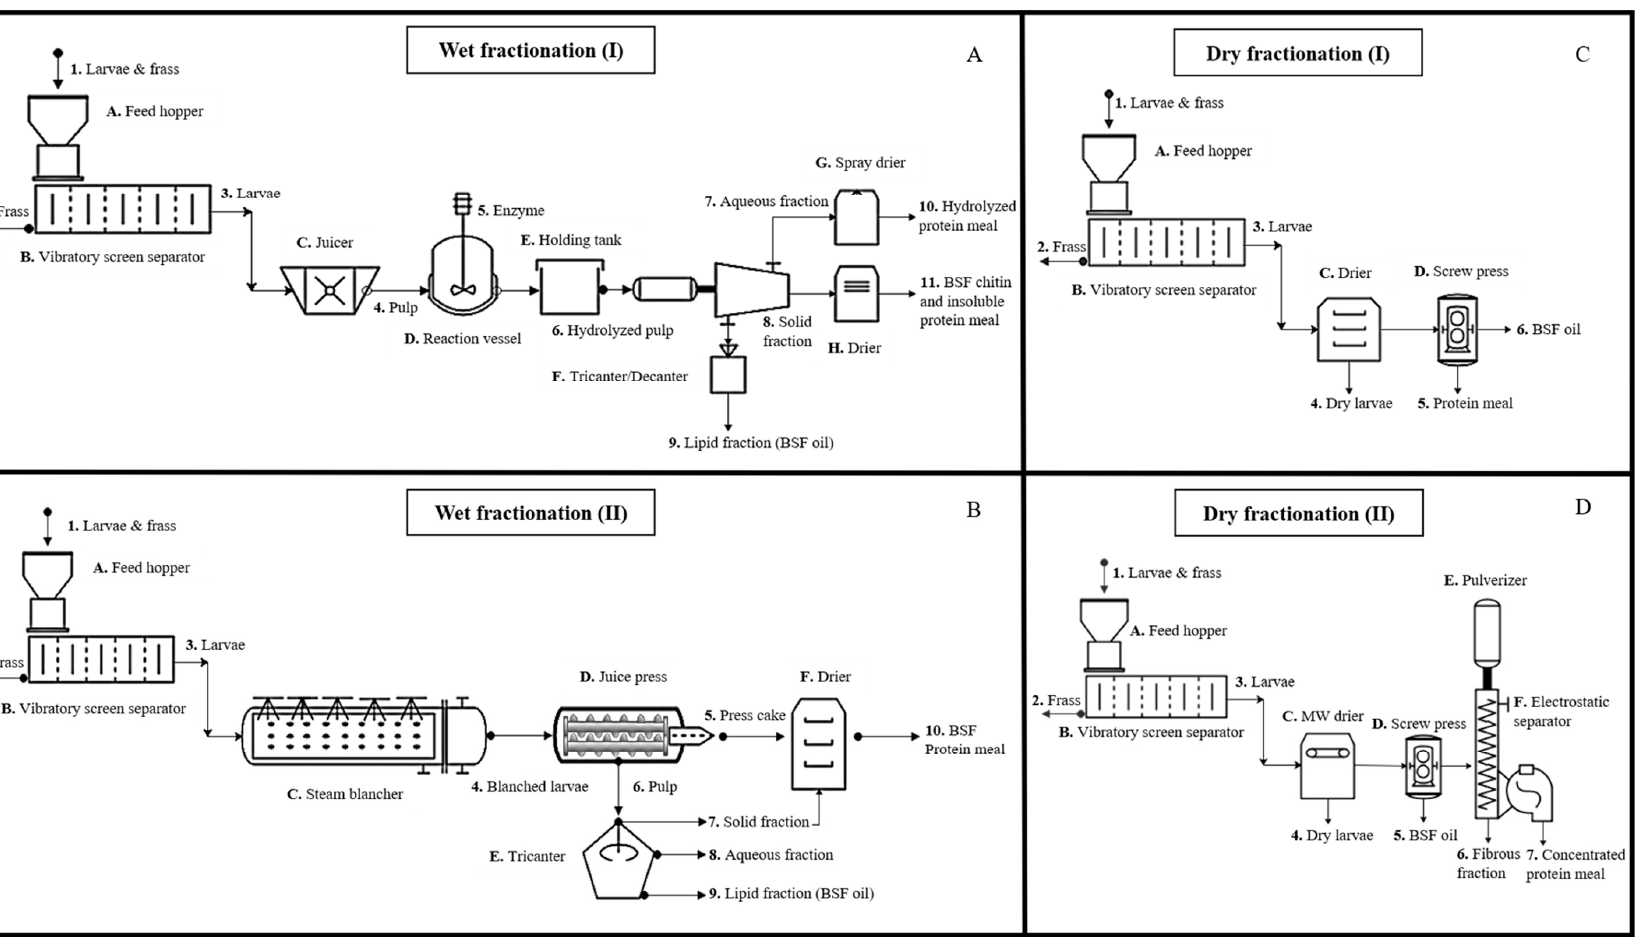
Figure 5. Unit operations in wet and dry fractionation of BSFL: An industrial-scale purview. ( A ) wet fractionation scheme with enzyme application ( B ) wet fractionation scheme with juice press ( C ) converntional dry fractionation ( D ) dry fractionation with an electrostatic separator.